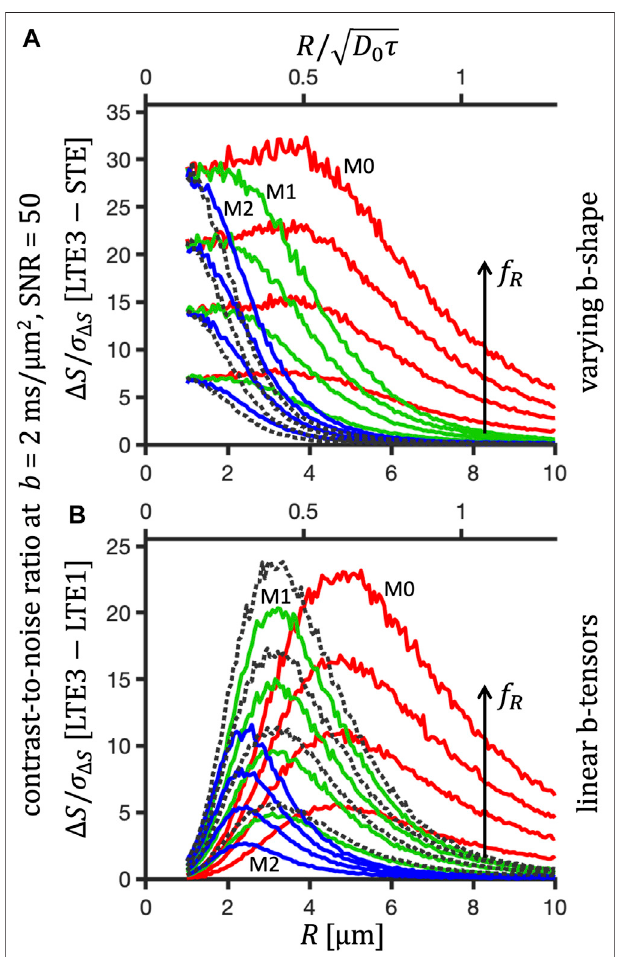
FIGURE10| SizesensitivityforcylindricalporesatSNR=50andvarying signal fractions f R . Contrast-to-noise ratio, Δ S / σ Δ S at b = 2 ms/ μ m 2 for diffusion restricted within cylindrical pores of varying radii R encoded with the M0- (red), M1- (green), M2- (blue) LTE1, LTE3 and STE preclinical waveforms and for the tuned, detuned and STE qMAS waveforms (black dotted). Substrate consists of compartments with hindered Gaussian ( D h = 1 μ m 2 /ms) and restricted diffusion ( D 0 = 2.48 μ m 2 /ms), with varying signal fractions f R =0.25,0.5,0.75,1correspondingtoincreasingsignaldifferences. Differences between rotation-averaged signals from LTE3 (or detuned qMAS) and STE (A) and from LTE1 and LTE3 (or tuned and detuned qMAS) (B) were calculated, yielding average and standard deviation values subject to noise, Δ S and σ Δ S , the ratios of which are shown in A and